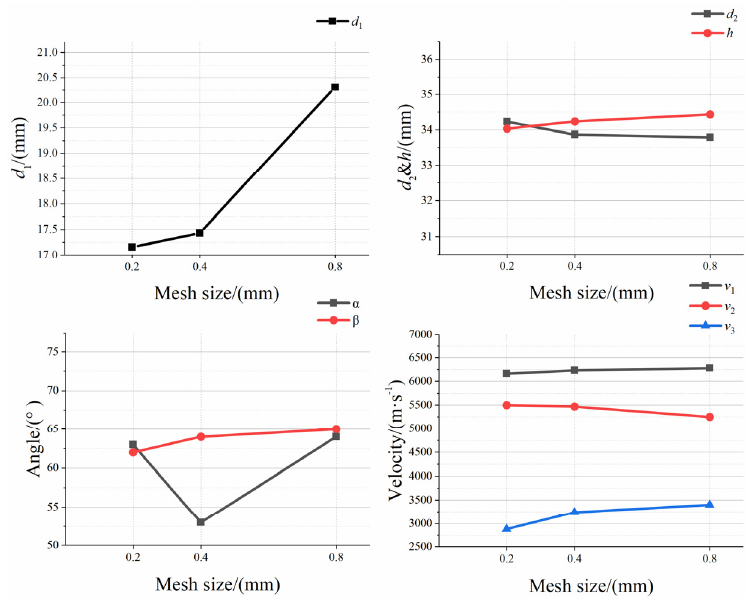
Figure 13. Curves of characteristic parameter values under different mesh sizes.